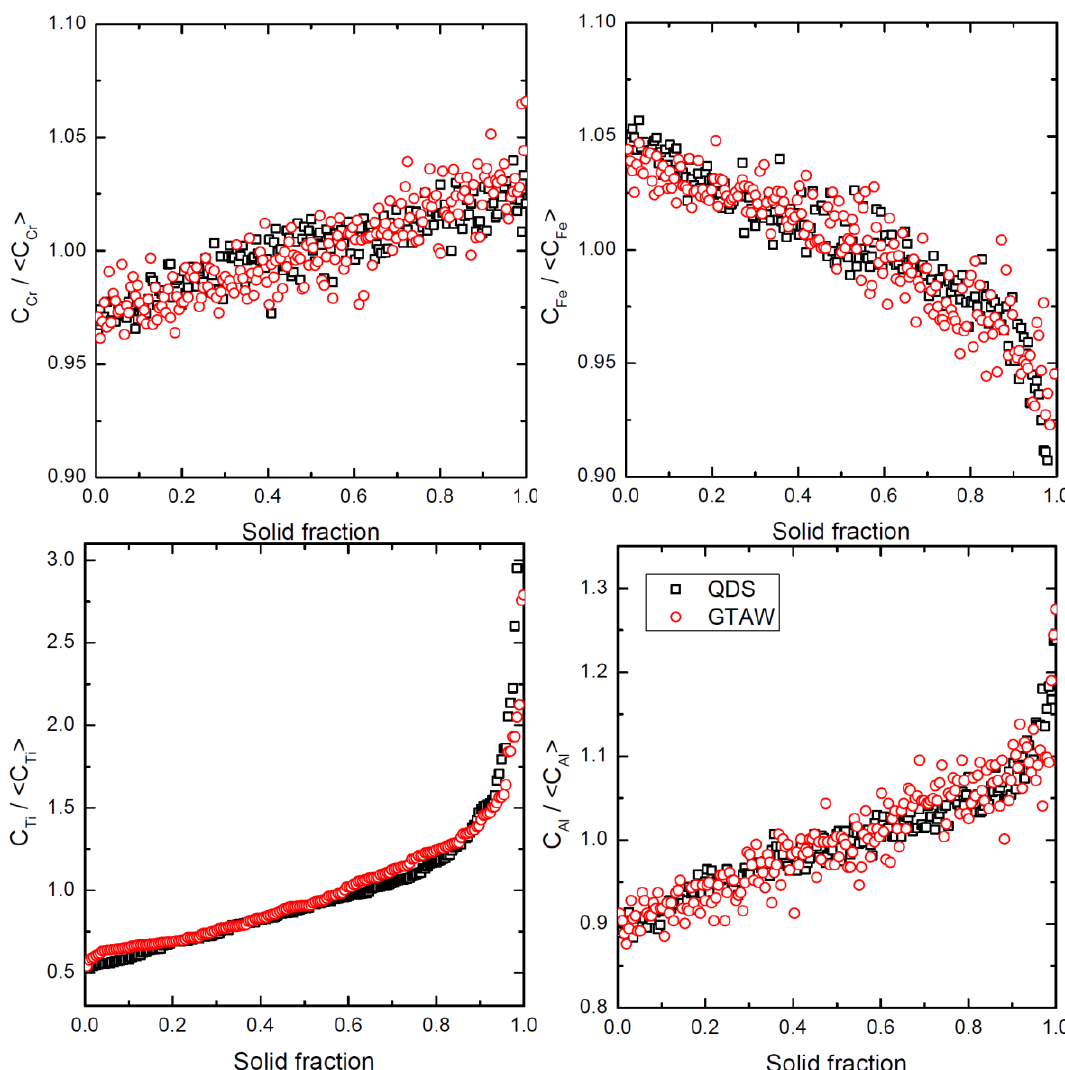
Figure 3. Comparison of microsegregation profiles between QDS, GV = 0.477 K/s and GTAW experiments. Table 4. Partition coefficients QDS, GTAW, and Thermo-Calc calculations.